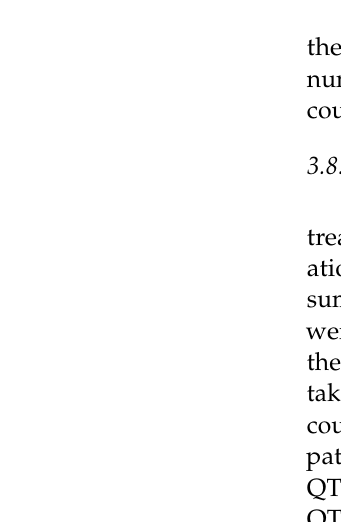
Multiple Cox Regression